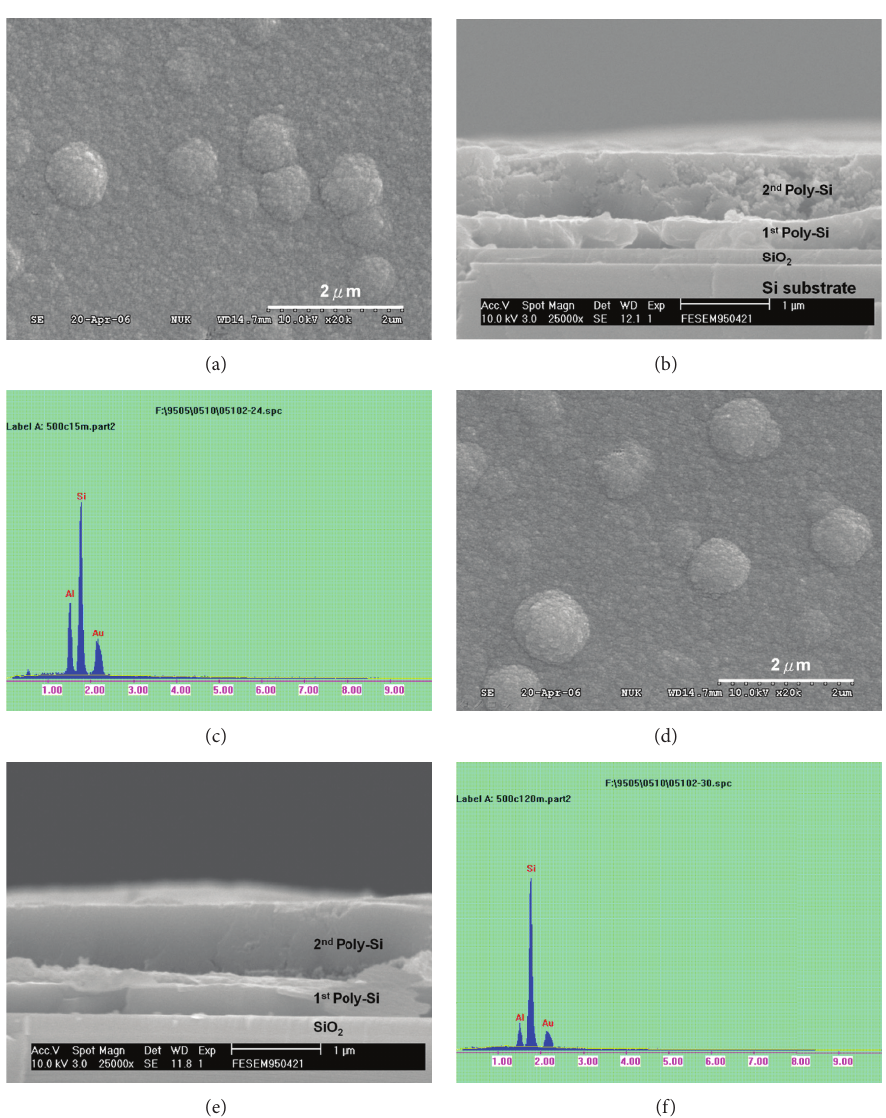
Figure 4: SEM images and EDS results of induced poly-Si thin films annealed for various durations: (a) 15min, top view; (b) 15min, cross- sectional view; (c) 15min, EDS results; (d) 120min, top view; (e) 120min, cross-sectional view; and (f) 120 min, EDS